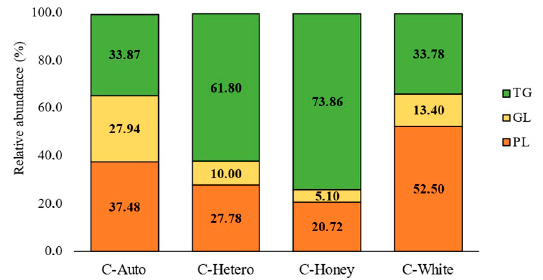
Figure 2. Graphical representation of the relative abundances (%), calculated by the sum of the normalized peak areas, of each main lipid group (phospholipids, glycolipids, and triacylglycerols) identified in the four C. vulgaris strains (C-Auto, C-Hetero, C-Honey, and C-White). GL—glycolipids; PL—phospholipids; TG—triacylglycerols.